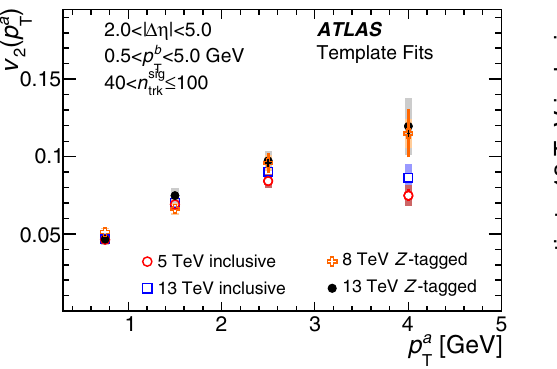
tively. Right panel: the ratio of the v 2 in 8 and 13 TeV Z -tagged samples to the v 2 in inclusive 13 TeV pp collisions as a function of p T . The hor- izontal dotted line indicates unity and is kept to guide the eye. Results ≤ 100 multiplicity are plotted for the 40 < n sig trk